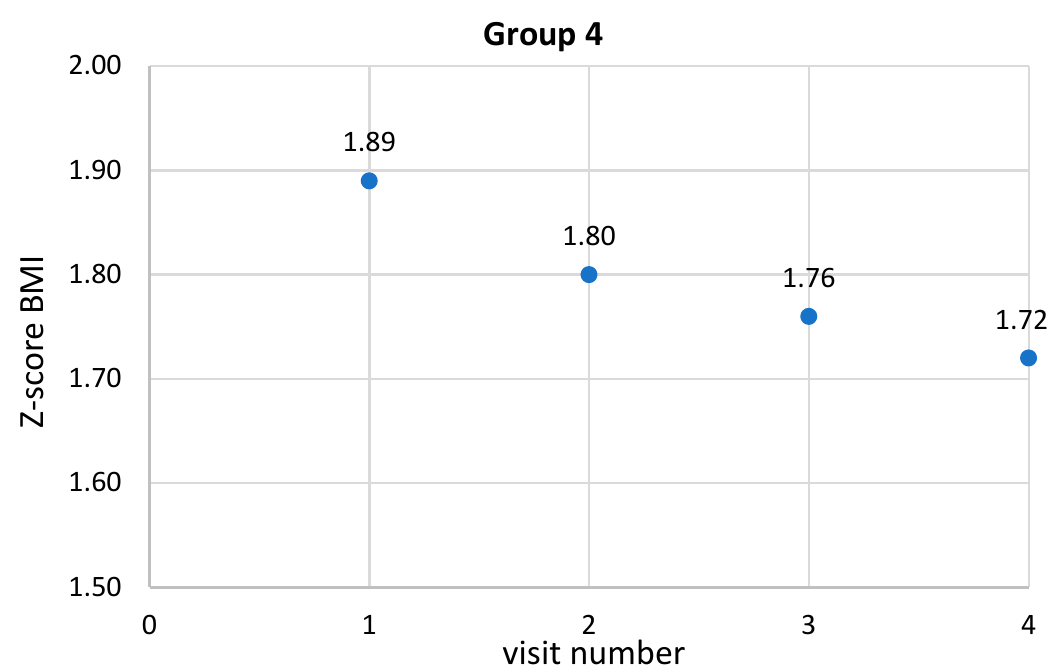
Figure 4. Change in BMI percentile during subsequent intervention visits.